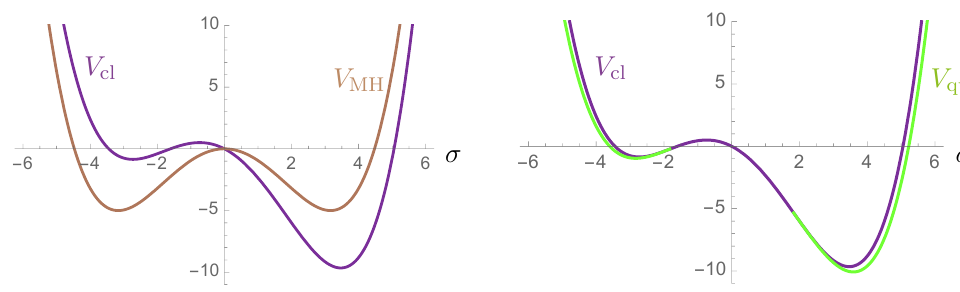
(cid:27) 4 along the in(cid:13)adron 2